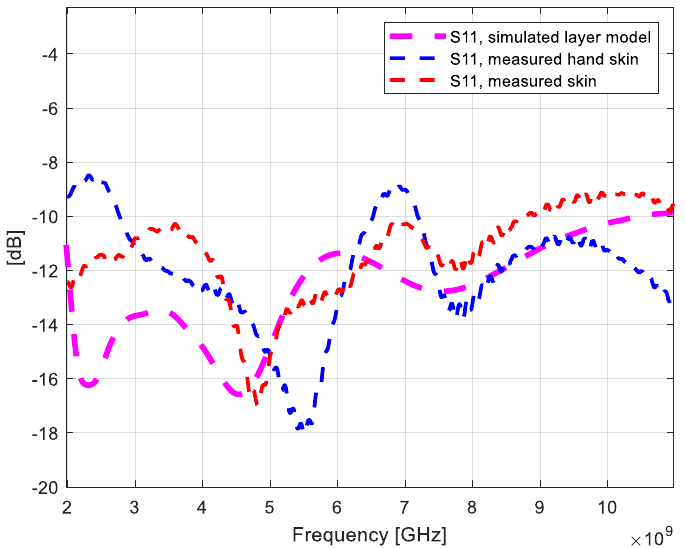
Figure 10. Comparison of the S11 parameters obtained by layer model simulations and measurements on the hand (with and without the cloth). Table 3. Measured and simulated total efficiencies at different antenna-skin distances. Frequency [GHz] Simulated, a-s = 0 mm [dB] −15.5